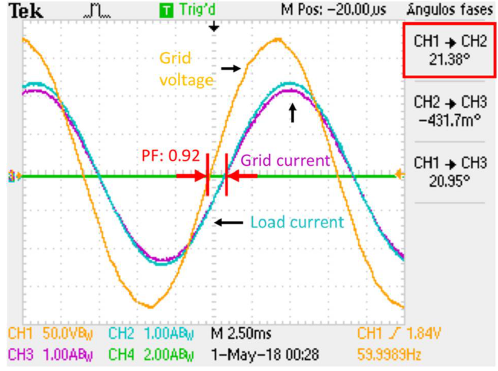
Figure 11. Power factor to improve.